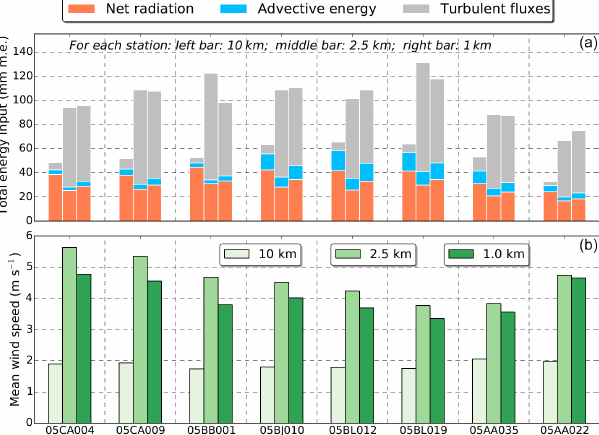
Figure 13. (a) Contribution of the different energy balance terms to the total averaged energy input to the snowpack (expressed in millimeter melt equivalent) during the flooding event simulated us- ing atmospheric forcing at different resolutions (left: 10km; mid- dle: 2.5km; right: 1km) and spatially averaged over all the snow- covered pixels of different subbasins. Hydrological simulations in configuration SND_GSD were considered. (b) Mean wind speed simulated using atmospheric forcing at different resolutions aver- aged over all the snow-covered pixels of different subbasins and the whole flooding